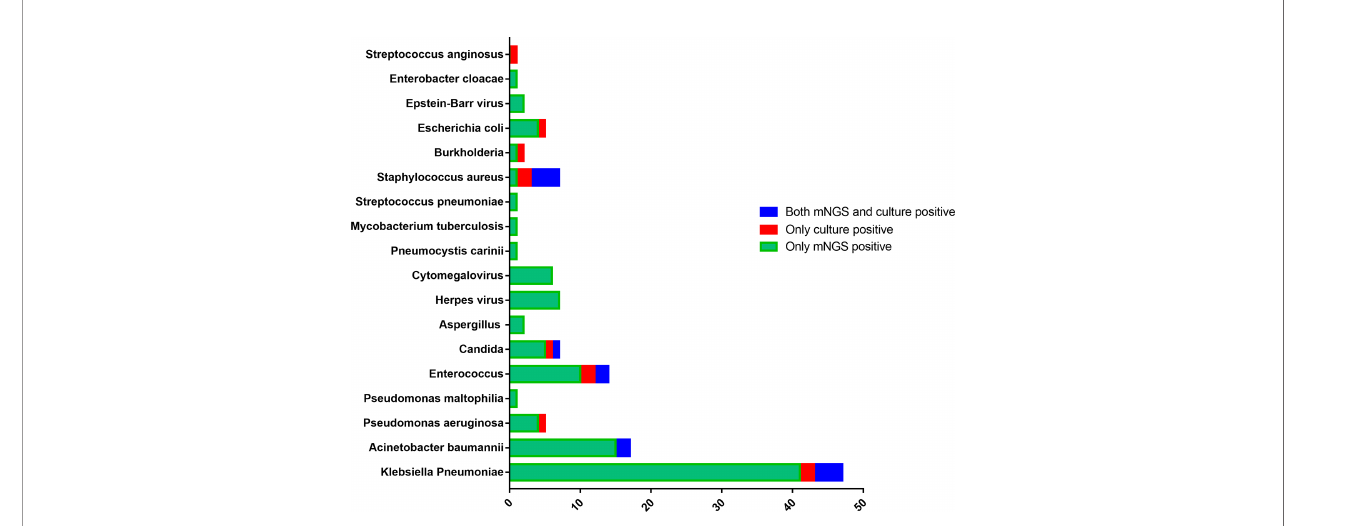
FIGURE 1 | Different pathogenic organisms (in numbers) in mNGS and microbial blood cultures.